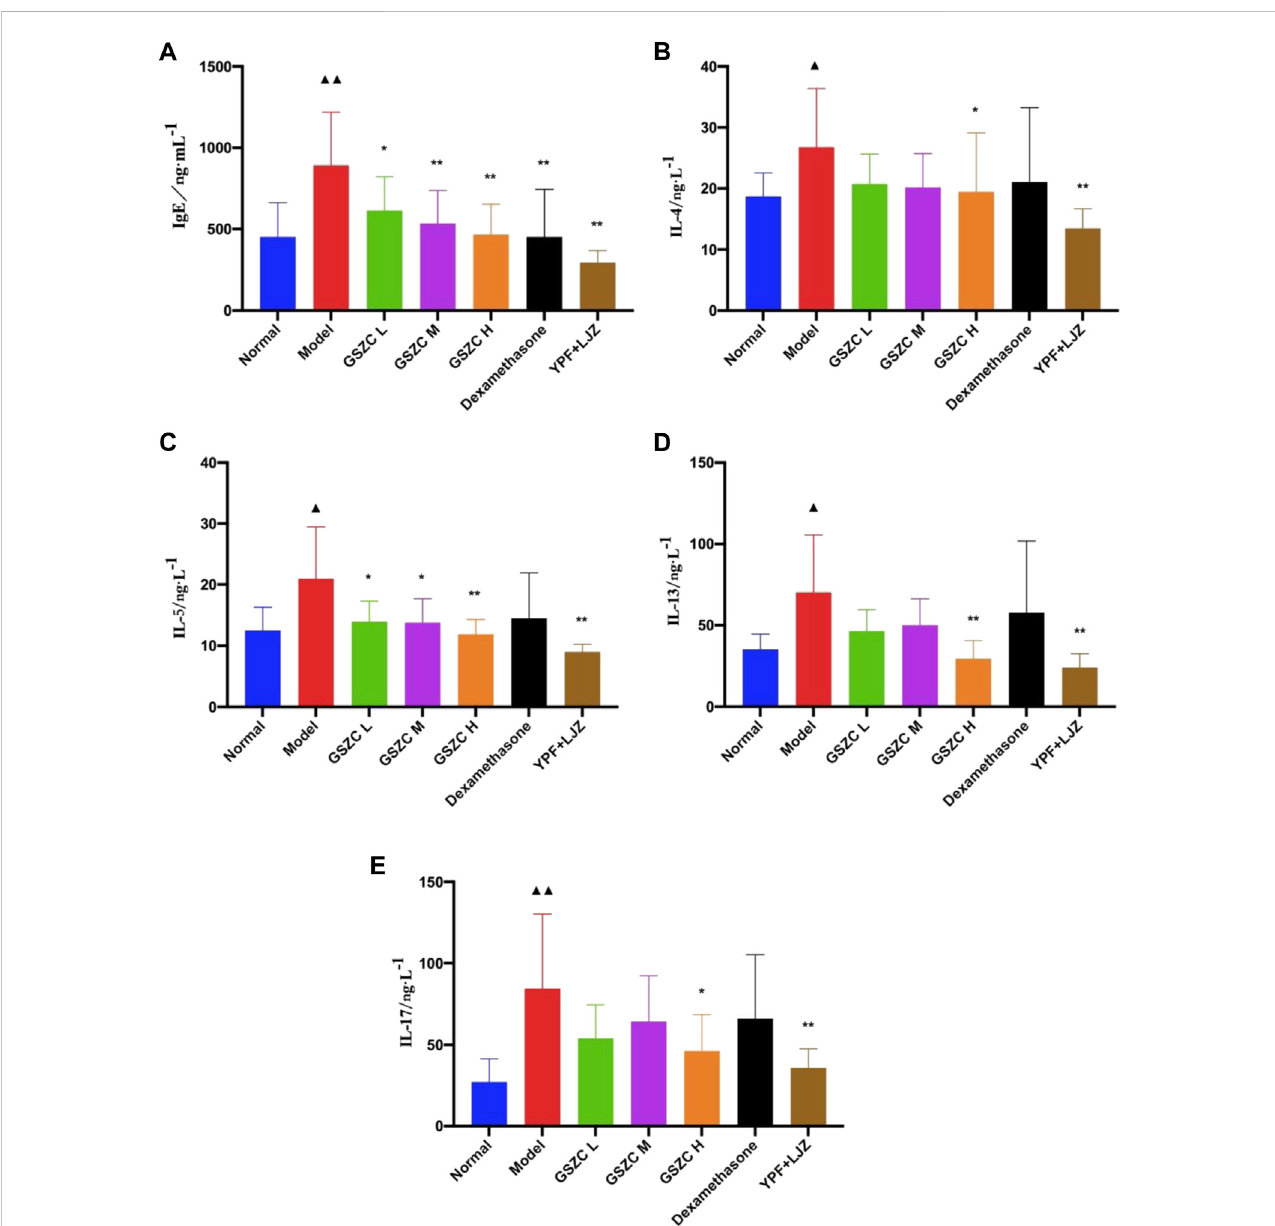
FIGURE 4 Effects of GSZC granules on serum IgE (A) , IL-4 (B) , IL-5 (C) , IL-13 (D) , IL-17 (E) in rats suffering from asthma. Values are the mean ± SD, n = 10 for each group. ▲ p < .05, ▲▲ p < .01 versus the normal group, * p < .05, ** p < .01 versus the model group.